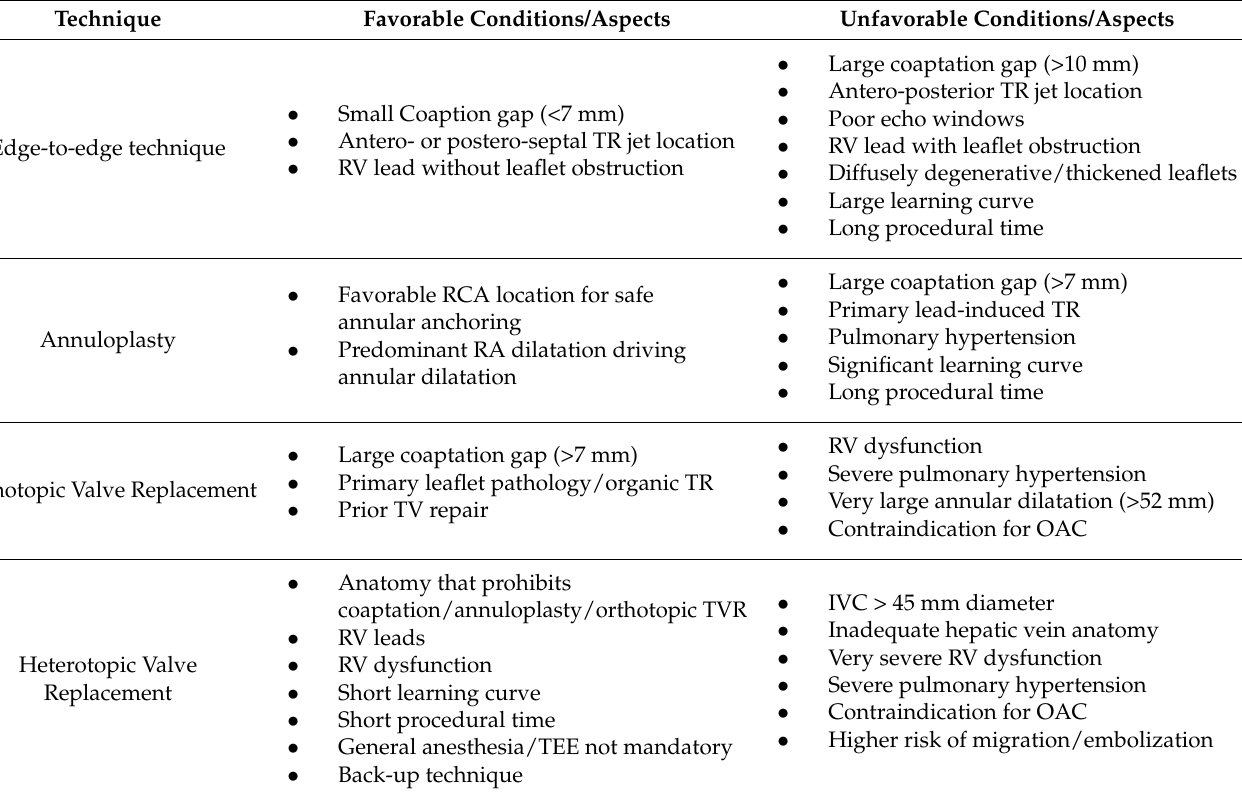
Table 1. Characteristics, advantages/disadvantages of percutaneous techniques for treating severe tricuspid regurgitation.